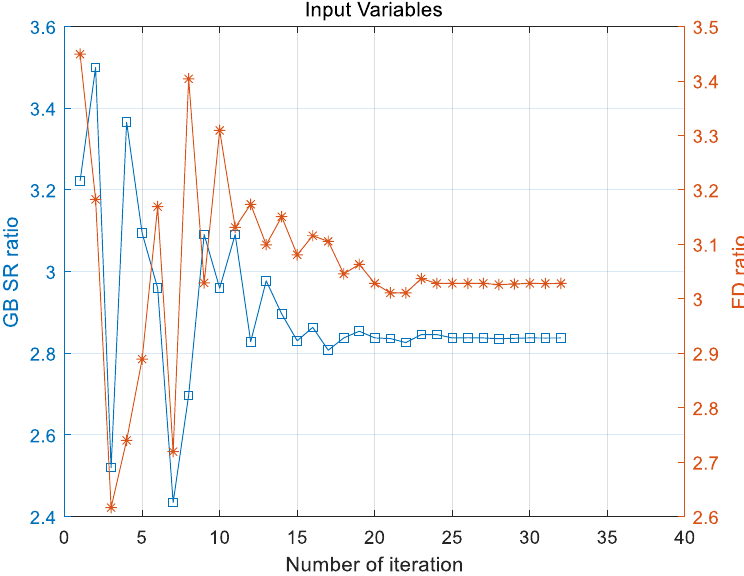
Figure 9. Optimization results for GB(blue, cube) and FD(orange, asterisk) ratios. Table 5. Component-sizing results and acceleration performance for Case 2.